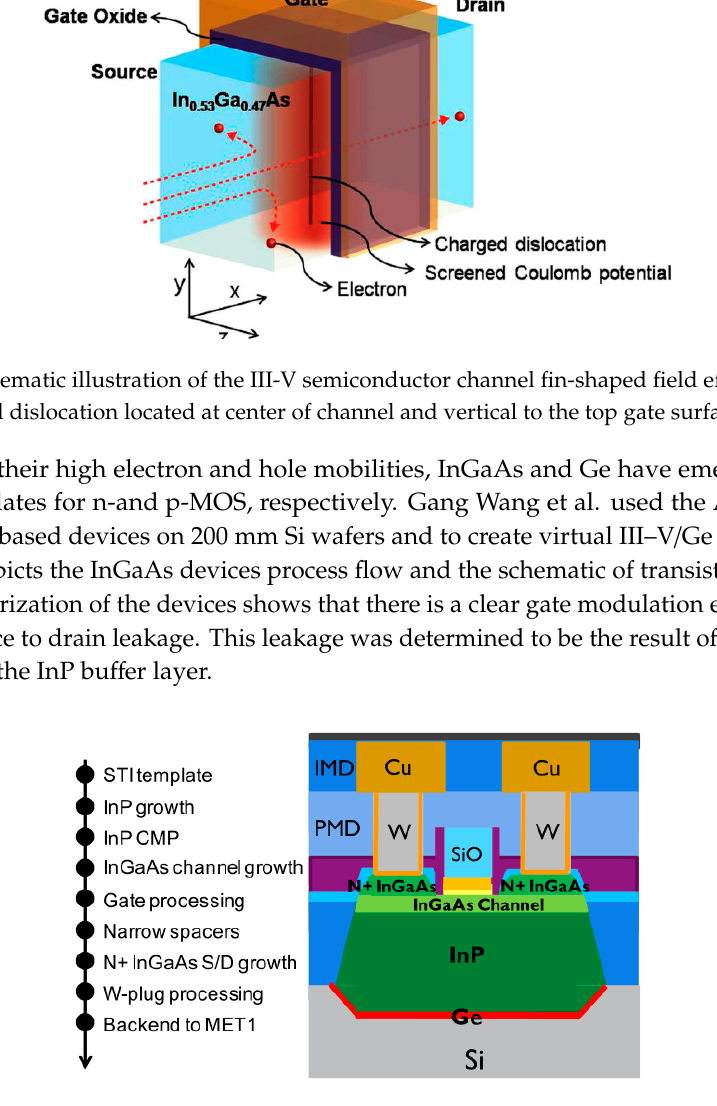
Figure 53. Process flow of InGaAs devices fabricated on 200 mm Si wafers and schematic of transistor structure [348].